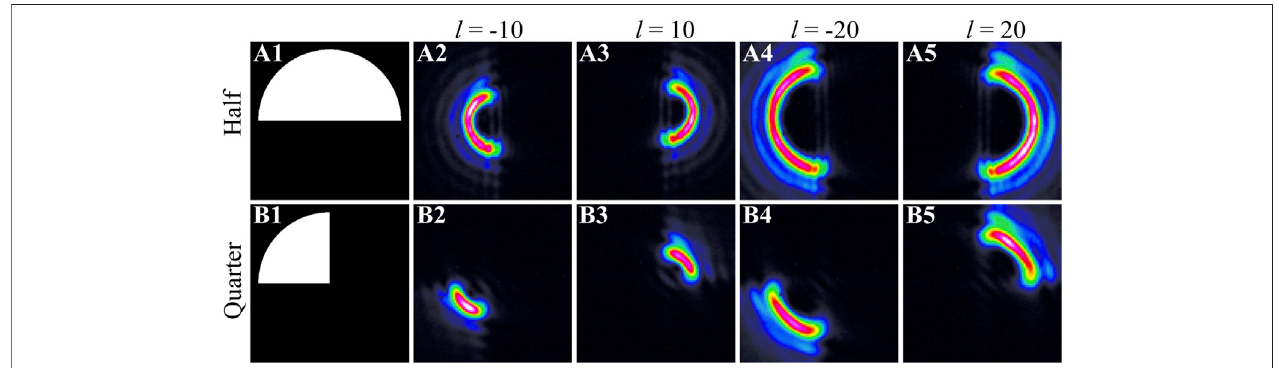
FIGURE8| Experimentallyobservedfocusingproperty ofvortexbeams. (A1) and (B1) arethesketchdiagrams ofahalfandaquartercircularpupilat z =0planes, respectively. (A2 – A5) aretheintensitydistributionsinthefocal fi eldforvortexbeamswithahalfcircularpupilinthecaseofthetopologicalcharge l tobe − 10,10, − 20,and 20, respectively, and (B2 – B5) are the corresponding measured intensity distributions for the vortex beam with a quarter circular pupil. (A) and (B) have the same dimensions of 1 mm × 1